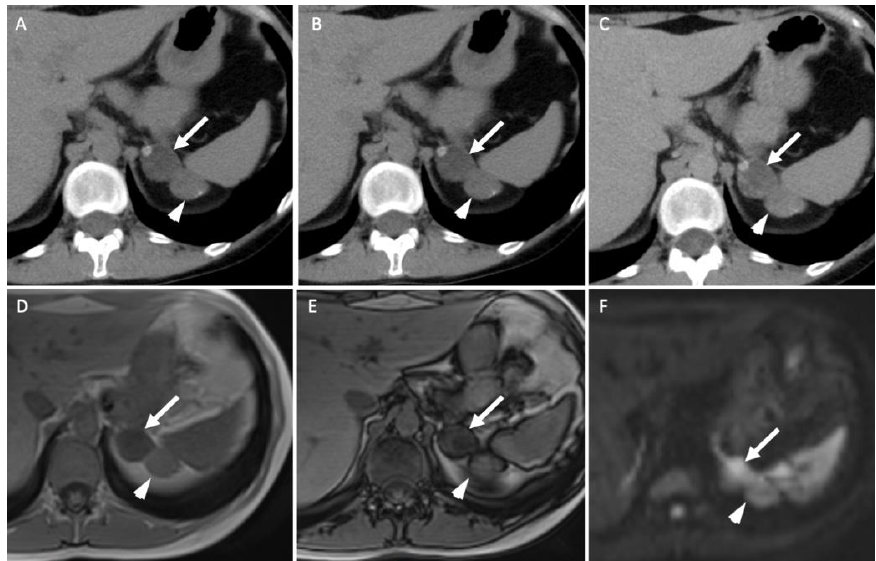
Figure 3. A 45-year-old woman with ACTH-independent Cushing syndrome. Unenhanced ( A ) and contrast-enhanced CT images obtained at 60 s ( B ) and 10 min ( C ) after intravenous administration of iodinated contrast material in the axial plane show two adrenal nodules in the left adrenal gland. The anterior nodule (arrows) has attenuation values of −5 HU in the unenhanced image, 50 HU at 60 s and 17 HU at 10 min; the absolute washout is 0.69 and the relative washout is 0.66. The posterior nodule (arrowheads) has attenuation values of 20 HU, 80 HU and 50 HU; the absolute washout is 0.50 and the relative washout is 0.38, which are not associated with a typical benign adrenal lesion. Unenhanced T1-weighted in-phase ( D ) and out-of-phase ( E ) MR images in the axial plane show a homogenous signal drop in the anterior nodule (arrow) in the out-of-phase image in comparison with the in-phase image and no signal drop in the posterior one (arrowhead). ( F ) The diffusion-weighted MR image (b = 1000 s/mm 2 ) in the axial plane reveals two adrenal nodules (arrow/arrowhead) with a signal intensity similar to that of the spleen. Because of the secreting syndrome and atypical imaging features, the patient had an “en bloc” resection. Pathological analysis revealed two benign adrenal adenomas with Weiss histopathological scores of 1 for the anterior nodule and 2 for the posterior one.